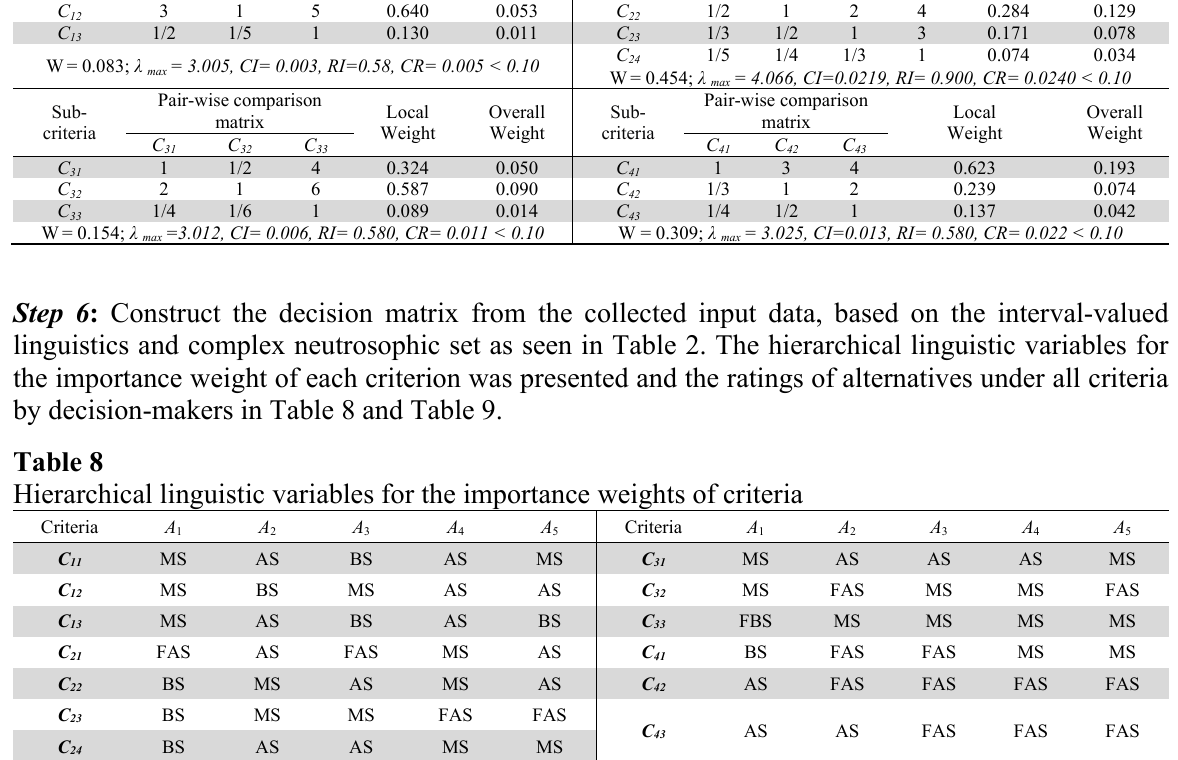
The values of pair-wise comparison matrices and weights of sub-criteria Pair-wise comparison Sub- matrix criteria